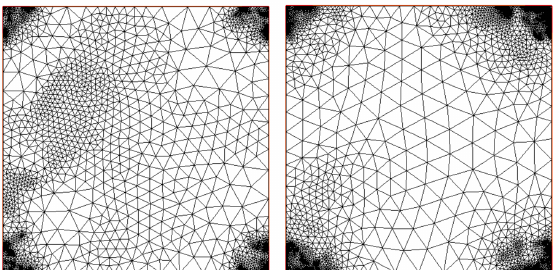
Figure 5. Adapted meshes for example 1 with the gradient recovery-based error estimator. ( Left ) The adapted mesh at the very last step and parameter c = auto . ( Right ) The mesh obtained at the last step with the estimator η Z and c = 0.3.